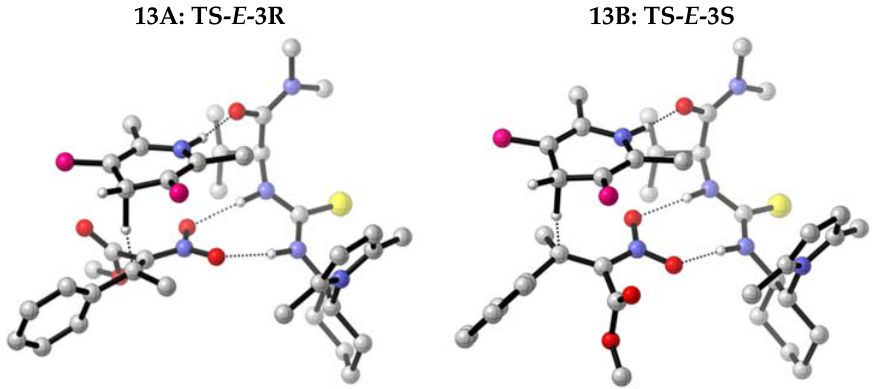
Figure 5. Transition states formed by the E - isomer of nitroacrylate 3a. The blue spheres represent the nitrogen atom of the nitro group of nitroalkane 3a and of the thiourea catalyst A , the yellow one represents the sulfur atom of the thiourea moi- ety, and the red spheres represent the oxygen atoms of nitro and ester groups of com- pound 3a, and of the carboxyamide group of the catalyst. The pink sphere represents the tert -butyl groups of the Han tz sch ester, carbon atoms are grey and hydrogen atoms are white. The broken lines showed the H-bonding interaction between the nitro group of 3a and the thiourea moiety of the catalyst, and the transfer hydride between Han tz sch ester and carbon C 3 of the nitroole fi n.